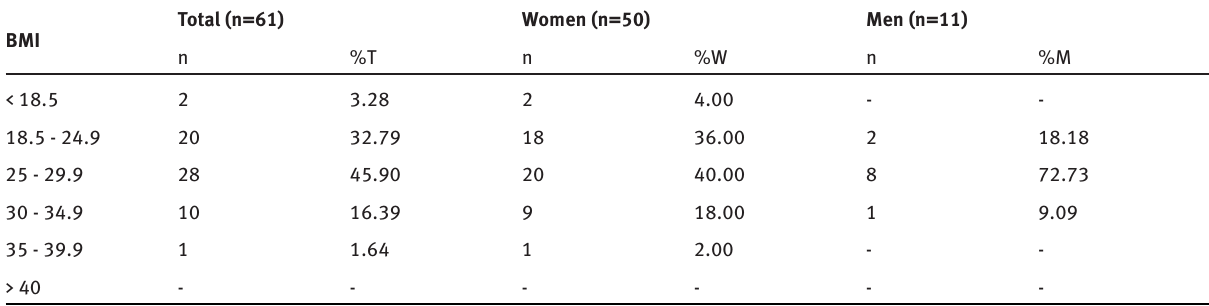
Table 2: The details of BMI of the students